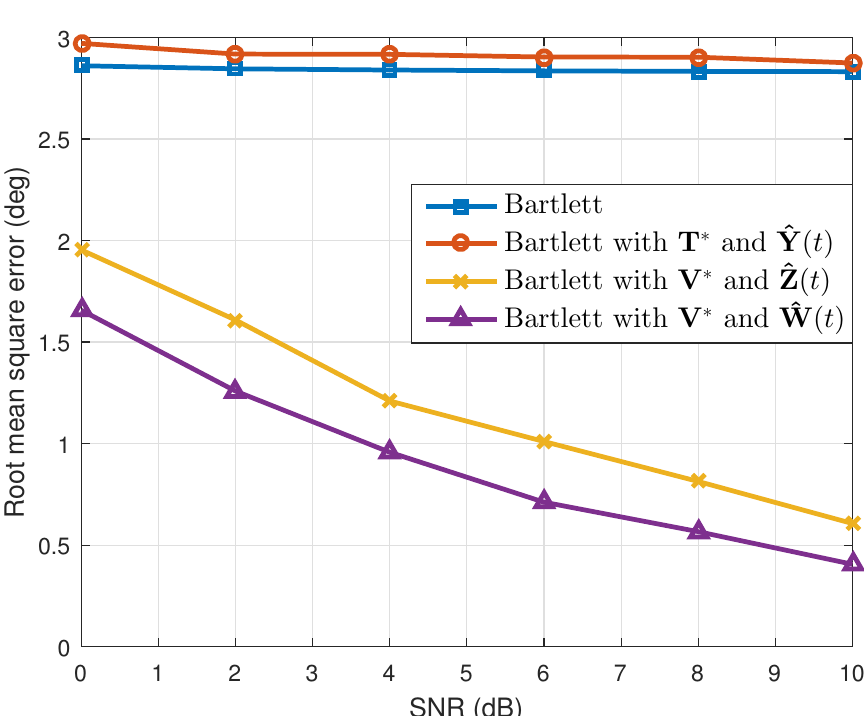
Figure 11. Root mean squared errors versus SNR ( N =